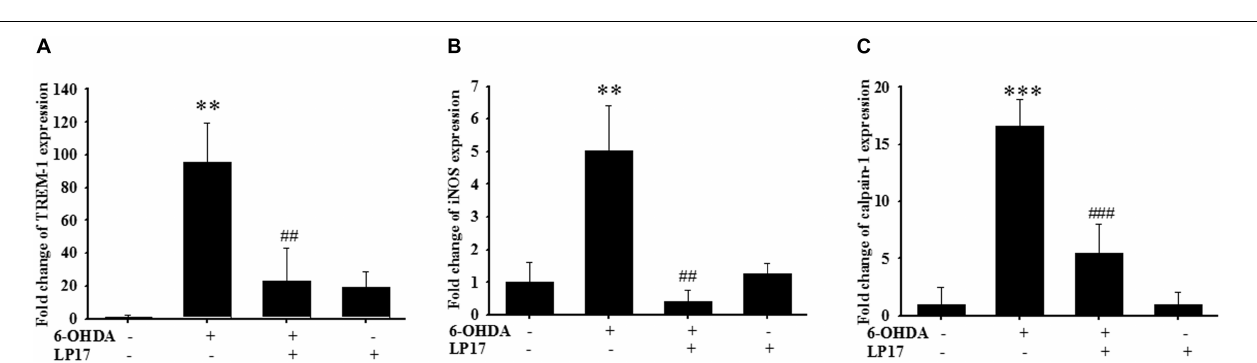
FIGURE 6 | LP17 attenuated the 6-OHDA-induced upregulation of TREM-1 and iNOS expressions in a zebrafish PD model ( n = 3/group). (A–C) The quantitative PCR of TREM-1, iNOS and calpain-1 expression of control, 6-OHDA, 6-OHDA plus LP17, and LP17 group after the zebrafish was treated with 0.1 µ g/ml of LP17 (from 9 hpf to 4 dpf) and 250 µ M 6-OHDA (from 2 to 4 dpf) at 4 dpf. LP17 attenuated the 6-OHDA-induced increase in TREM-1, iNOS, and calpain-1 mRNA expressions. Each sample contained 20 zebrafish heads. The bars represent the mean ± SEM. The data were analyzed using two-way ANOVA. ∗∗ P < 0.05 versus the control group; ## P < 0.05 versus the 6-OHDA